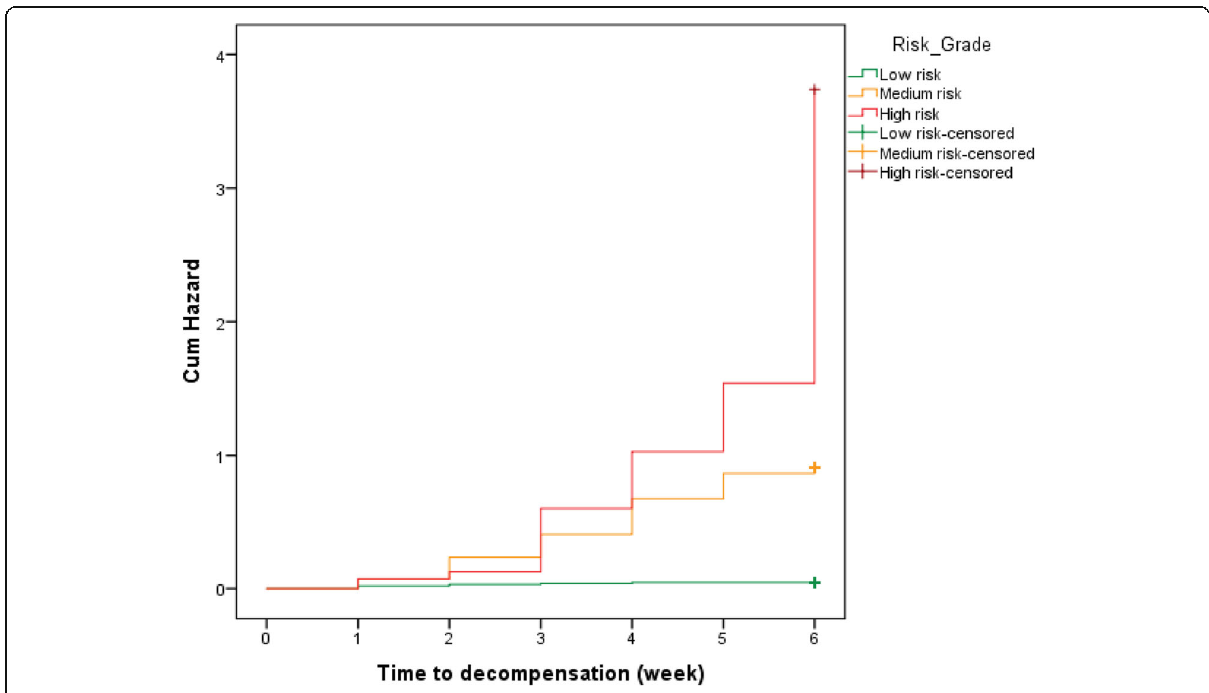
Fig. 5 Hazard function of the proposed